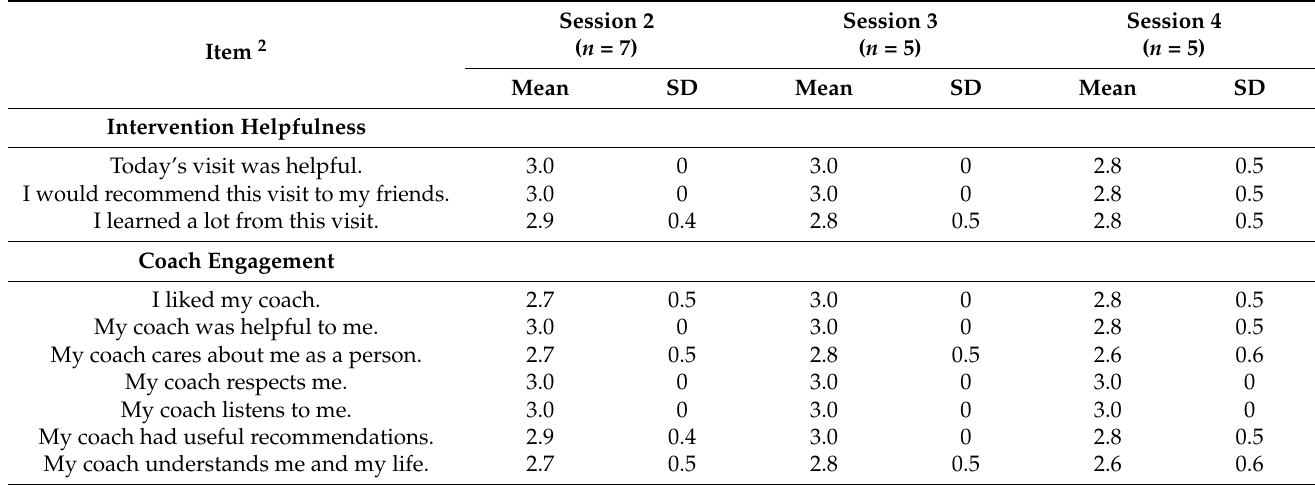
Table 4. Co-caregivers’ responses to session helpfulness and coach engagement items 1